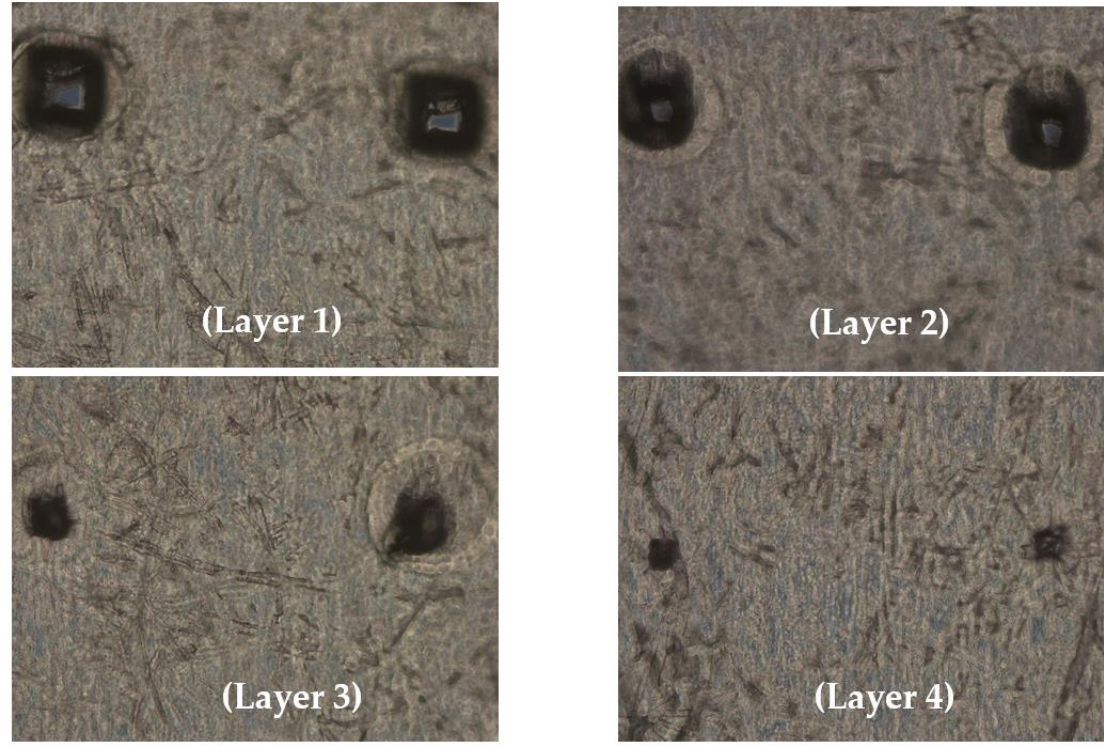
Figure 2. Optical microscopic image of Parafilm M treated with microneedles; the dissolving mi- croneedles penetrated 4 layers of Parafilm ® M.